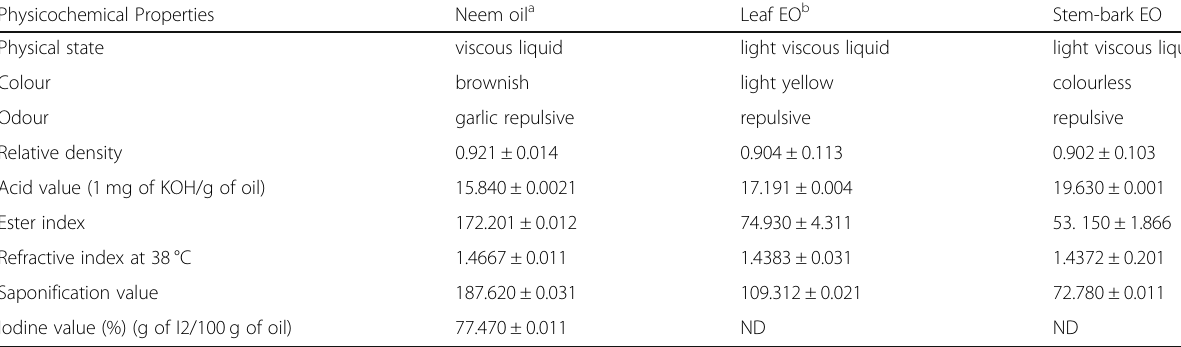
Table 7 Physicochemical of properties of neem oil and essential oil Physicochemical Properties